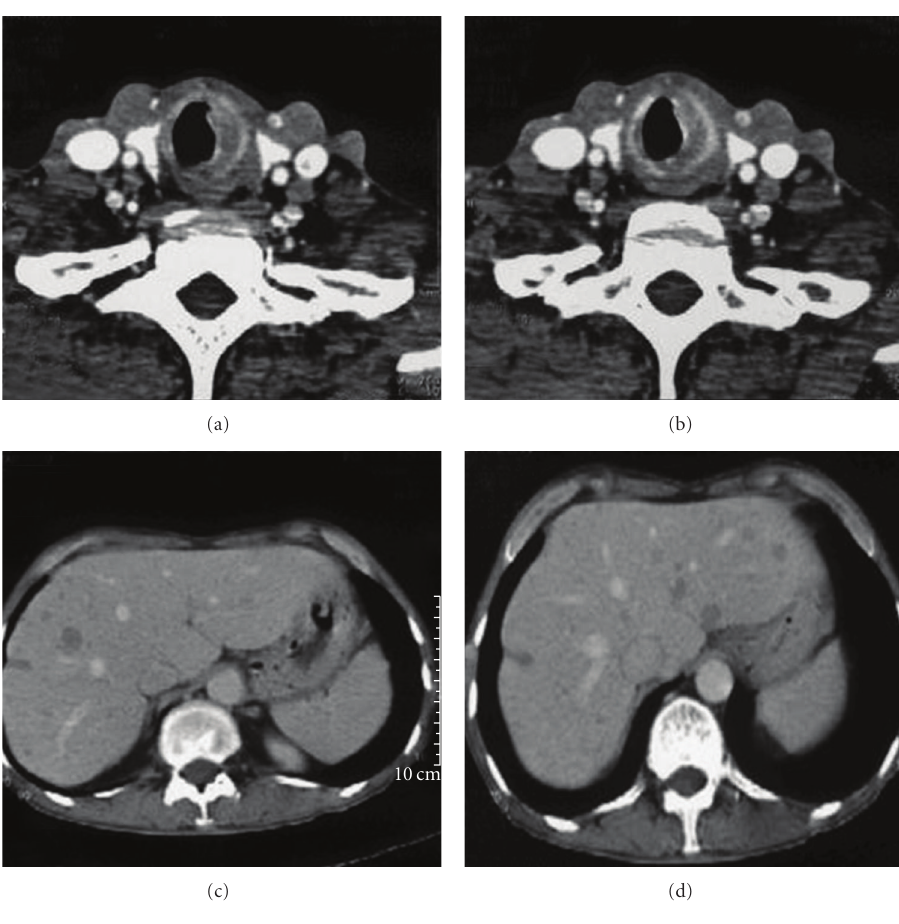
Figure 1: CT scan of the patient showing the primary tumor in the subglottic region.